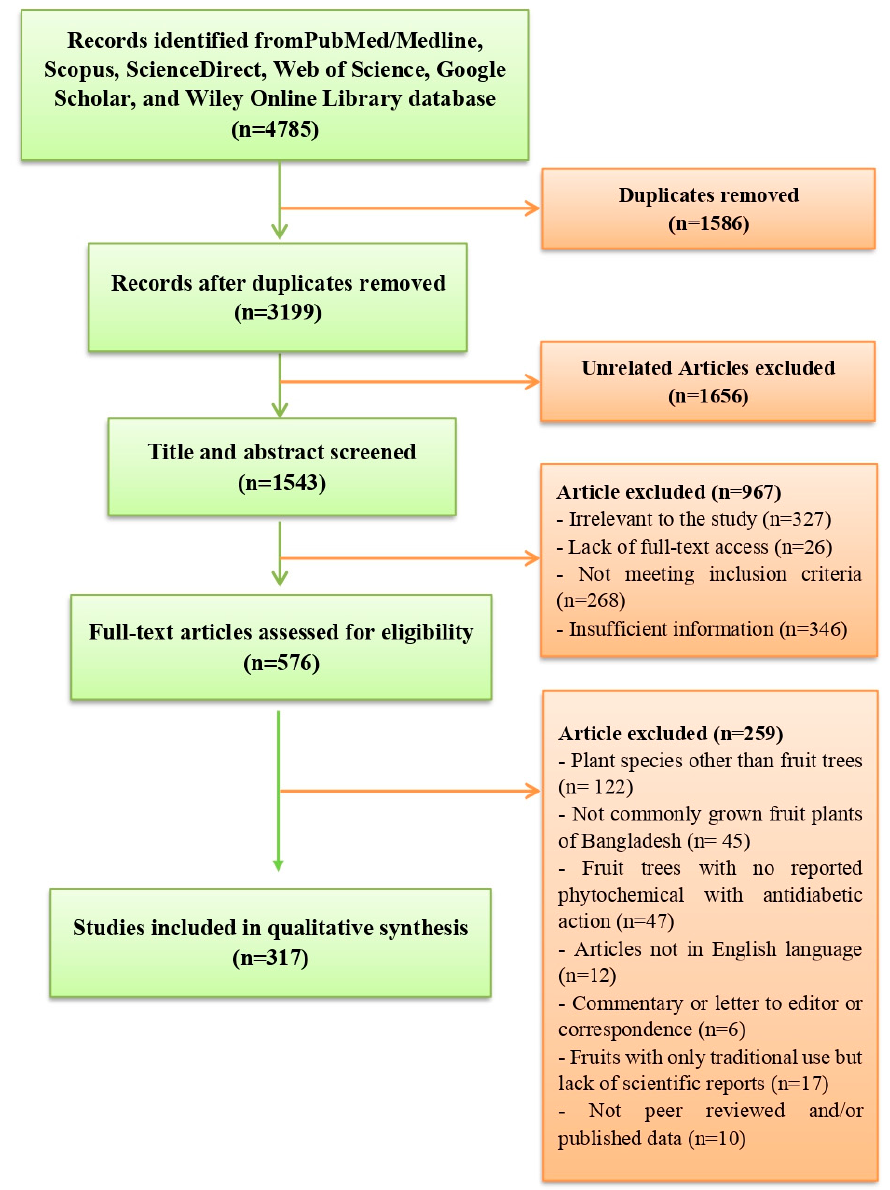
Figure 4. PRISMA for the identification and screening of articles to include in the study according to eligible